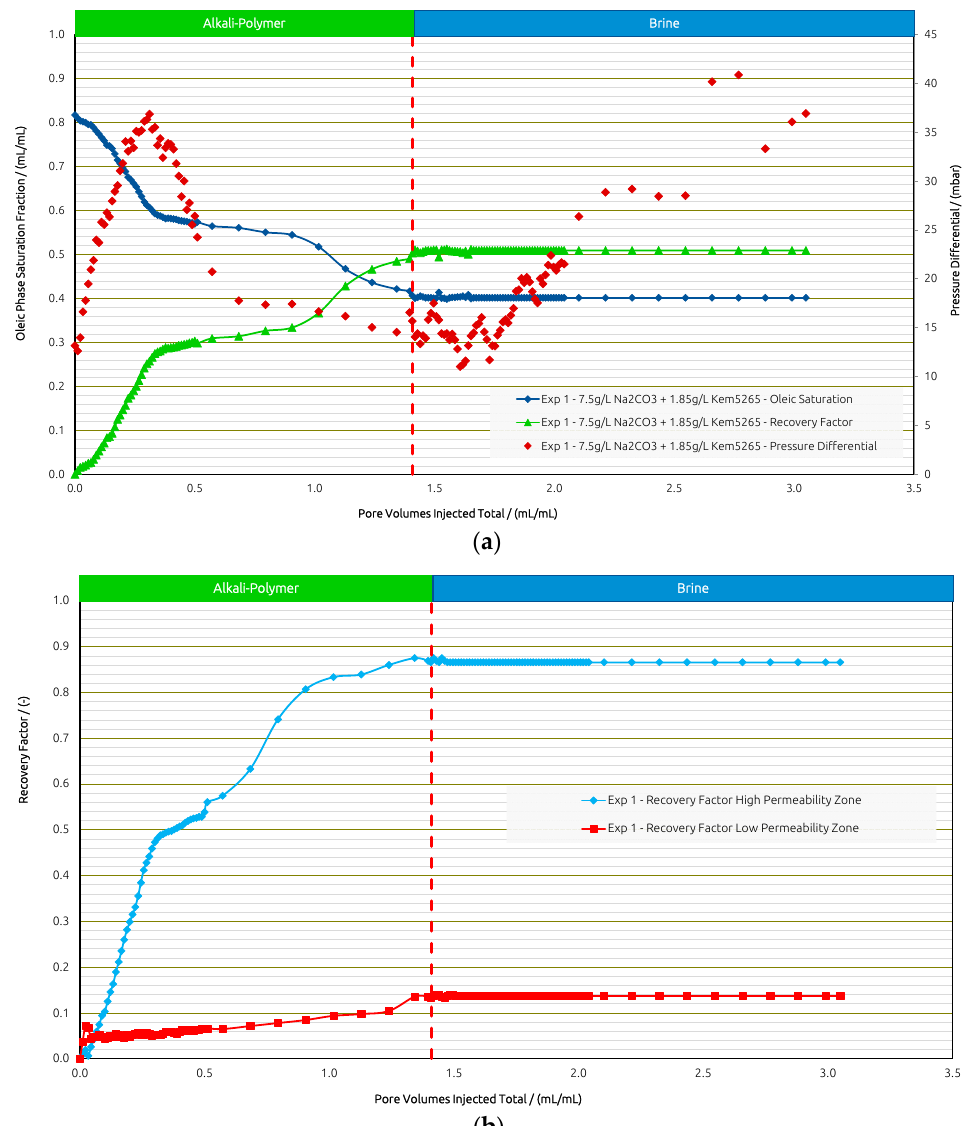
Figure 8. Summary of results obtained for Exp. 1 in micromodel experiments. ( a ) Oleic saturation, Recovery Factor (RF), and pressure differential for the entire chip and ( b ) RF of low-permeability zone vs. RF of high-permeability zone.